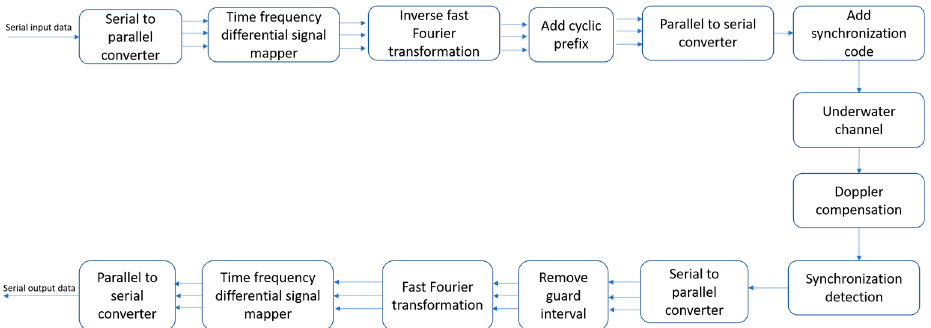
Figure 2 . Communication scheme of the OFDM approach. Figure 2. Communication scheme of the OFDM approach.